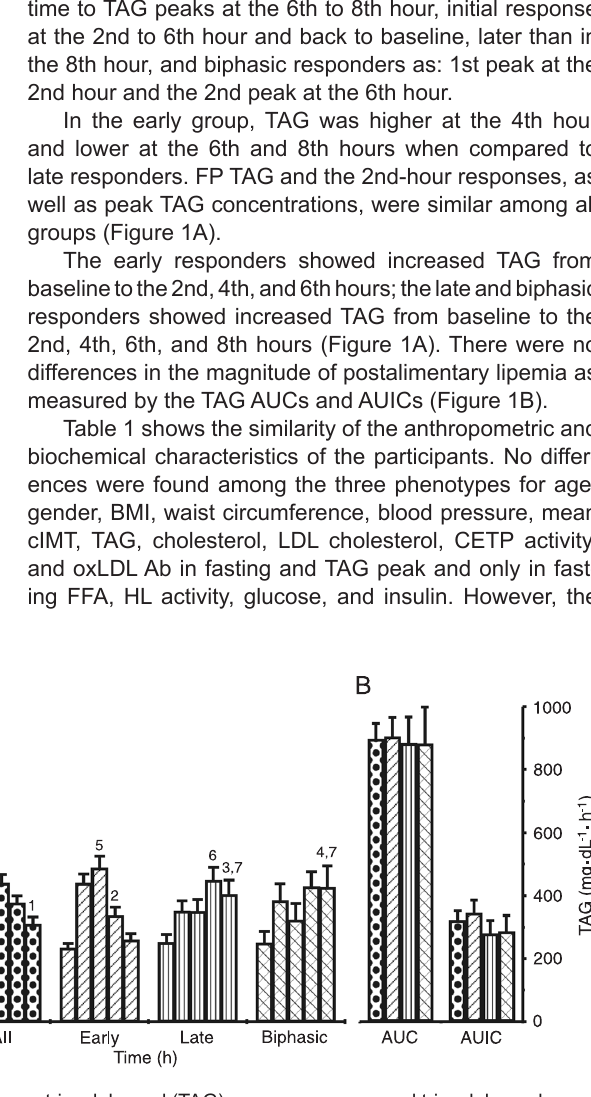
Figure 1. Plasma triacylglycerol (TAG) response groups and triacylglycerol areas under the curves (AUC) and areas under the incremental curves (AUIC) after